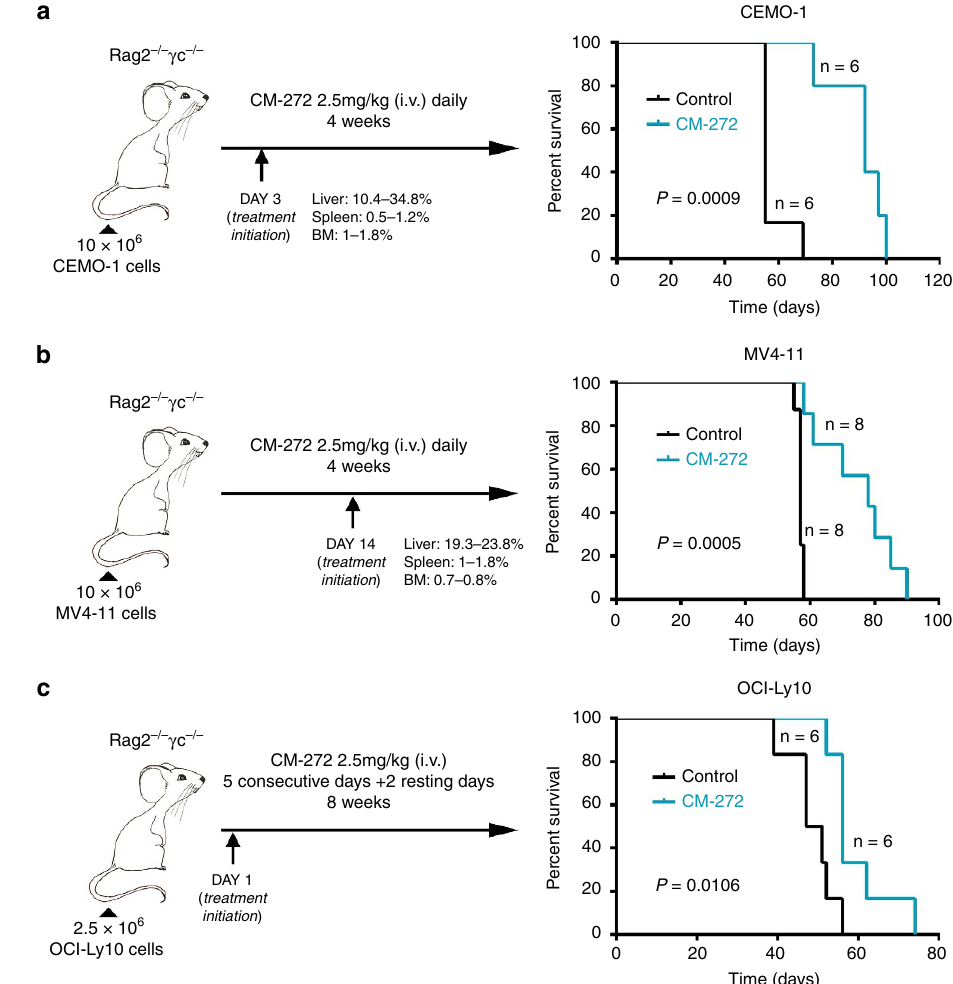
Figure 4 | CM-272 shows anti-leukaemic effects in vivo . Schematic diagram of in vivo CM-272 treatment procedure and Kaplan–Meier survival curves for evaluating the survival time of mice engrafted with ALL-derived CEMO-1 cells ( a ), AML-derived MV4-11 ( b ) and DLBCL-derived OCI-Ly10 ( c ) treated with CM-272. Infiltration levels in liver, spleen and bone marrow are indicated in the figure. Control: saline solution (diluent of CM-272). P values assessed by